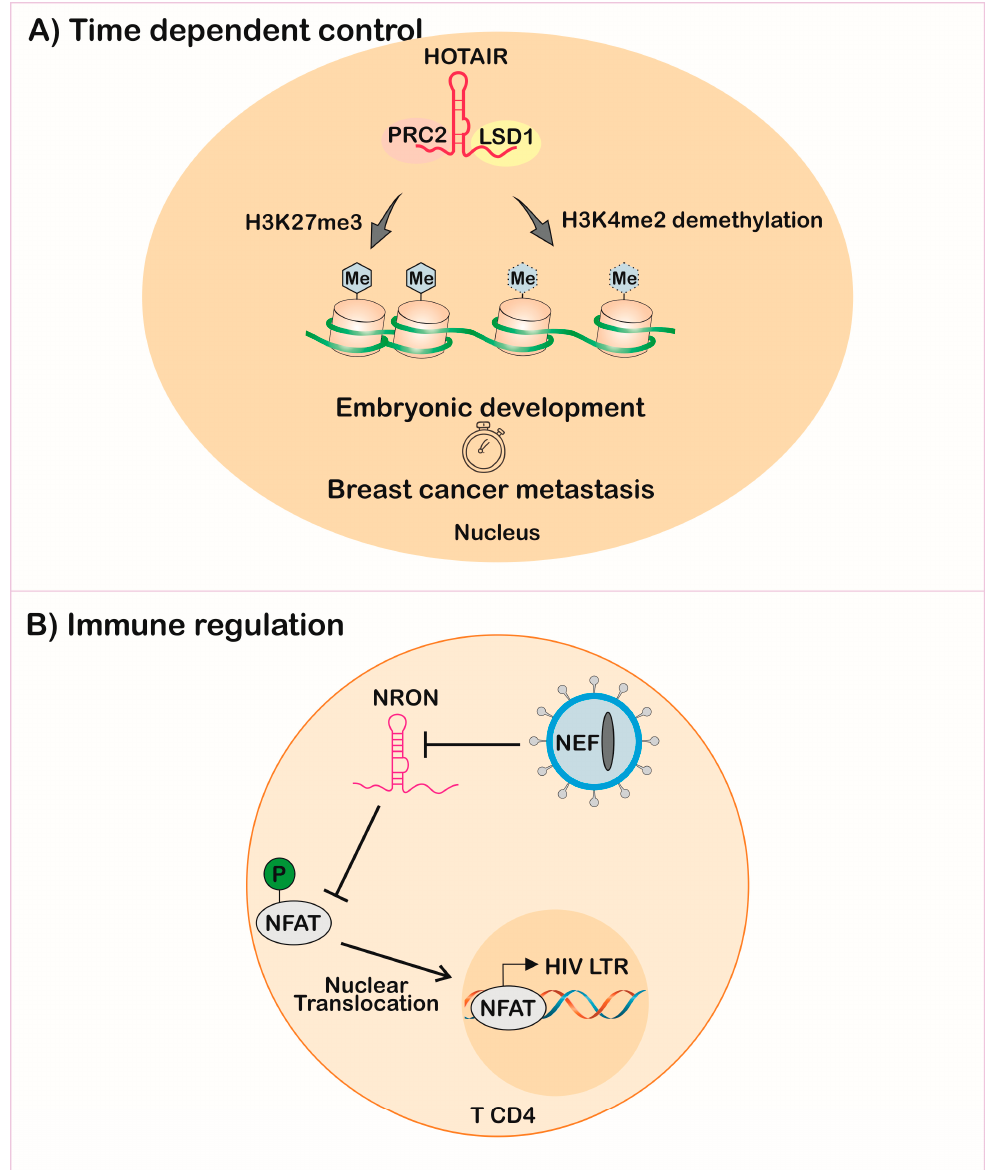
Figure 4. Patho-physiological implications of lncRNAs expression in a time- and infection-dependent manner. ( A ) Expression of HOTAIR complexed with PRC2 and LSD1 leads to trimethylation of the histone 3 at the lysine 27 and demethylation of the lysine 4, controlling gene expression during embryonic development, but leading to breast cancer metastasis when expressed in adult breast tissue; ( B ) disruption of the NRON lncRNA expression in T CD4+ lymphocyte by the HIV Nef protein leads to NFAT translocation to the nucleus and LTR transcription. Abbreviations: